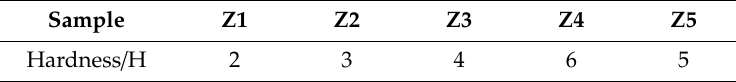
Table 3. Hardness of Z1, Z2, Z3, Z4, and Z5 composite